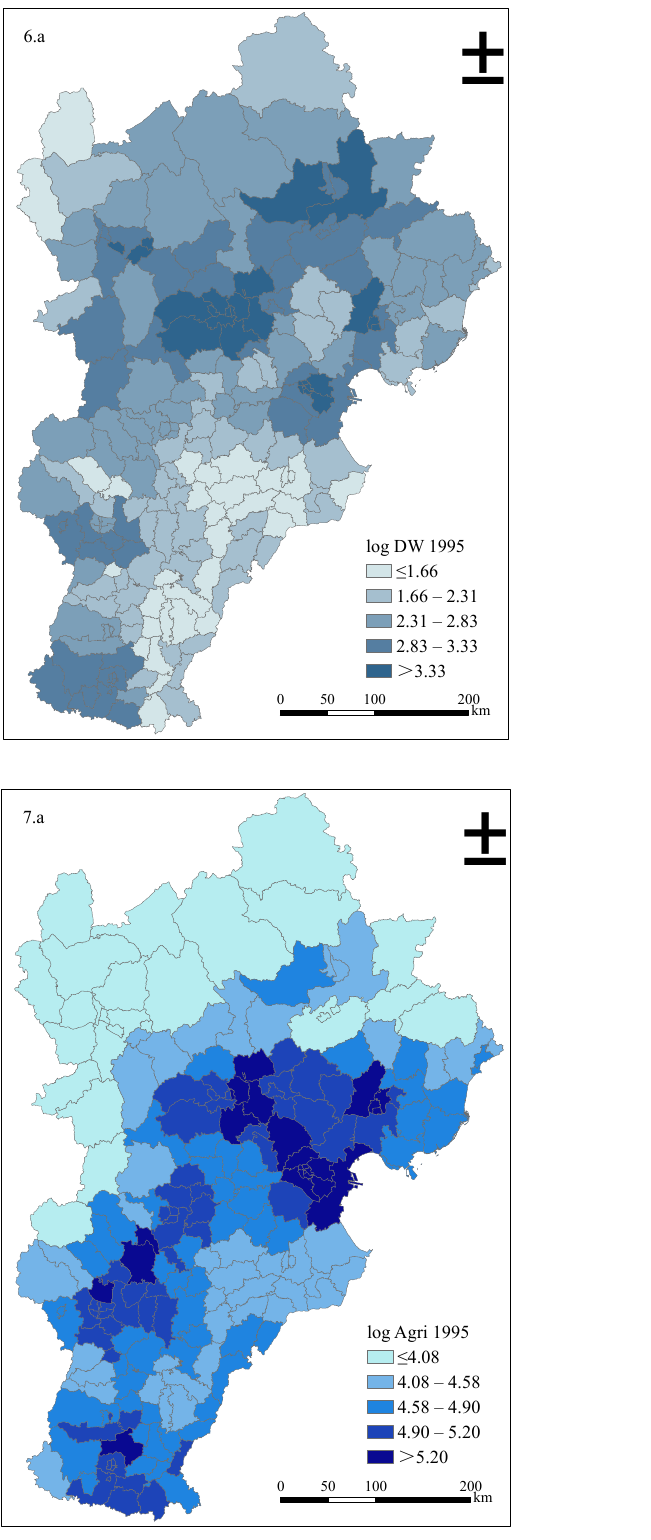
Figure 2. Spatio-temporal dynamics of log LD, log Tran, log RC, log Indu, log EP, log DW, and log Agri from 1995 to 2014 in Beijing–Tianjin–Hebei region.